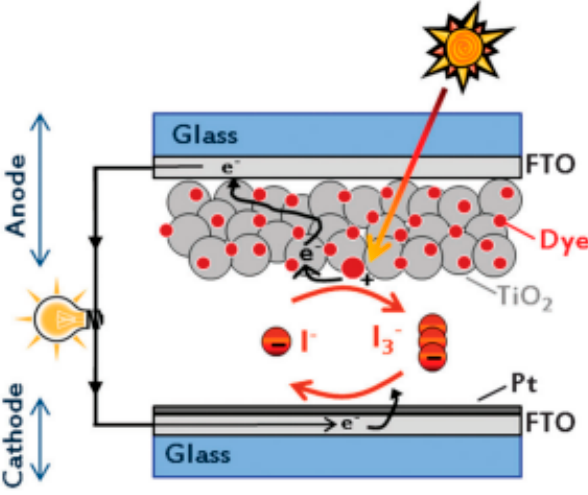
Figure 3. Schematic representation of the components and of the basic operating principle of a DSSC. Reproduced with permission from [71] .